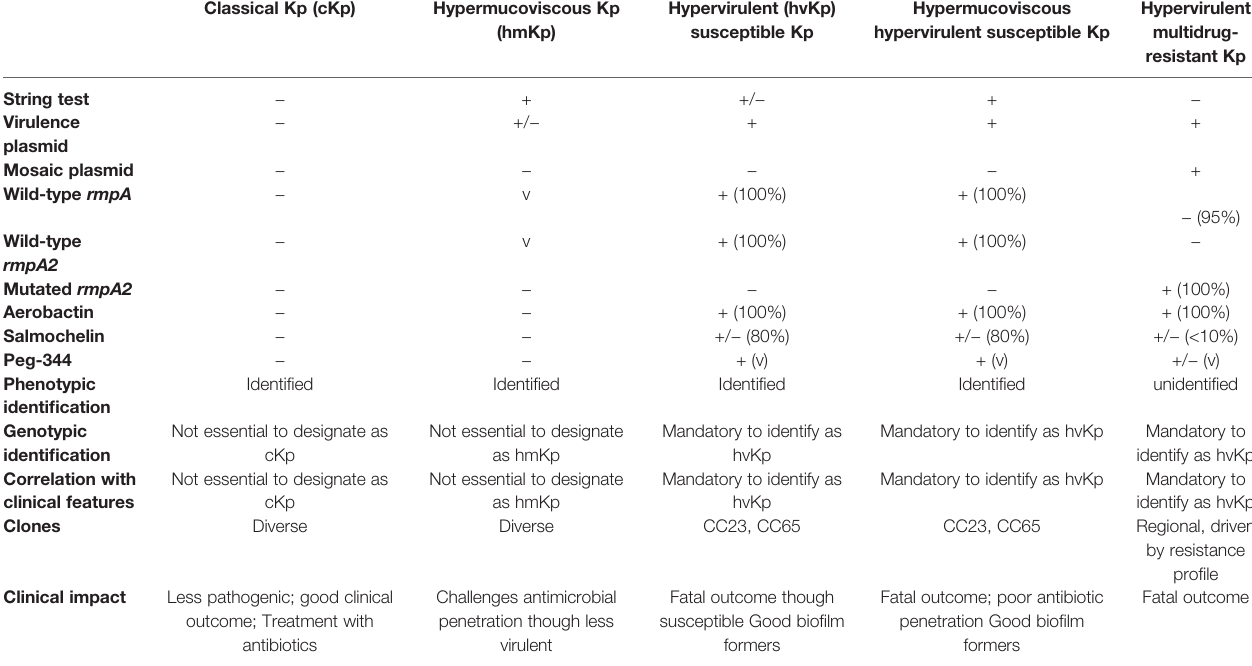
TABLE 2 | Key virulence markers among various pathotypes of Kp.